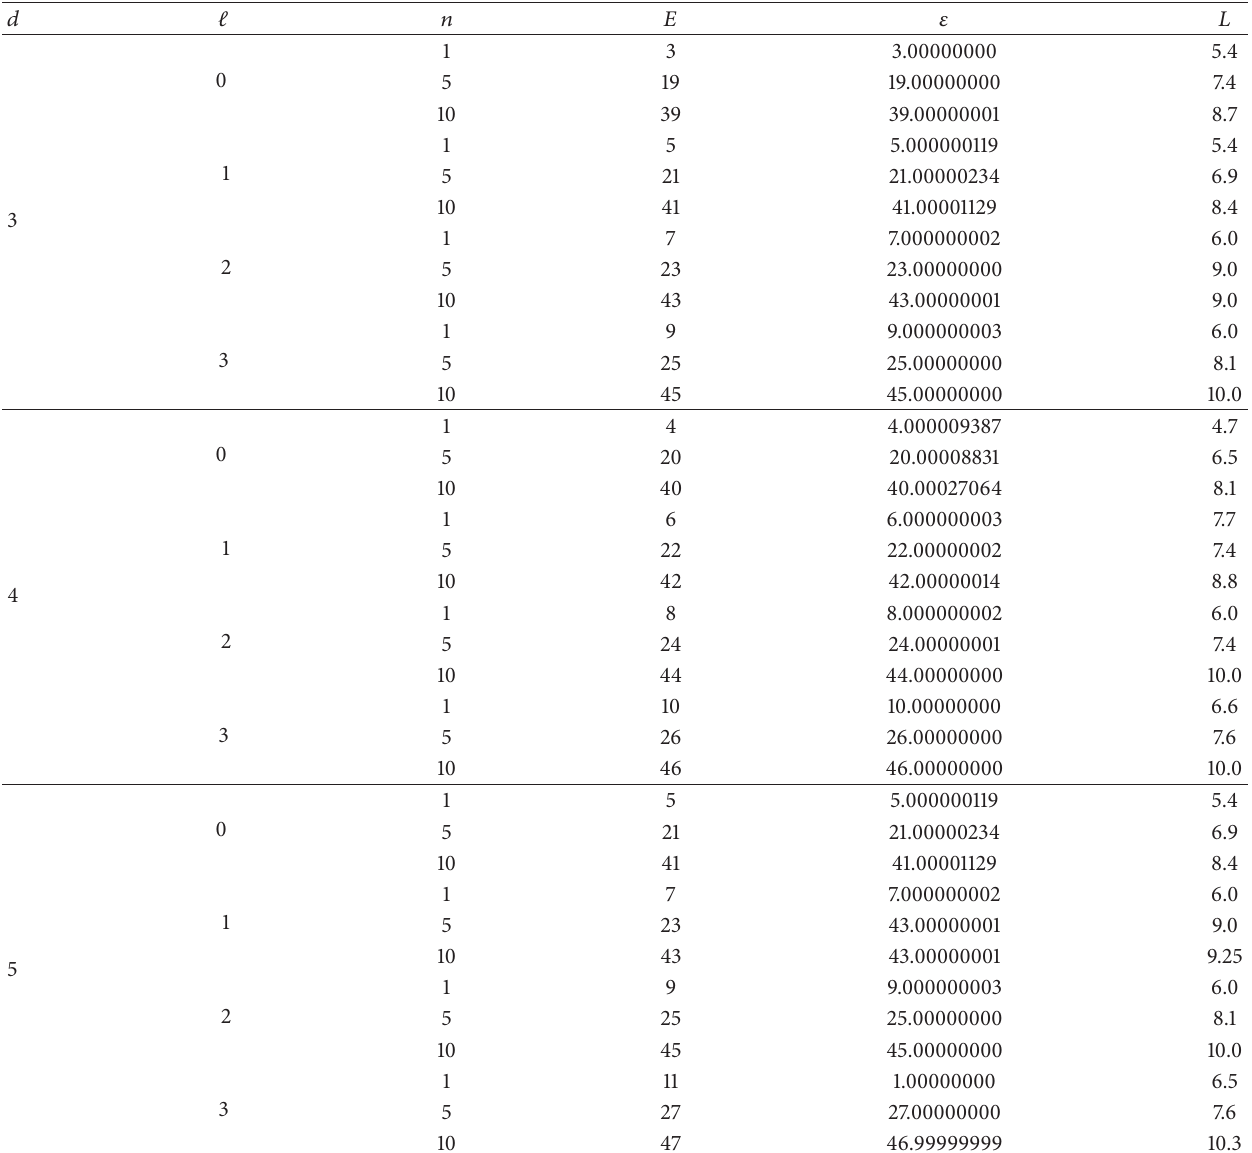
Table 4: Approximation of the energy levels of the harmonic oscillator in dimensions 𝑑 = 3, 4, 5 . 𝑛 represents the energy state, 𝐸 is the exact solution for the energy given by (12), and 𝜀 is the upper bound to 𝐸 obtained using the variational analysis. The eigenvalues 𝜀 𝑛 of H are minimized over 𝐿 . This table shows specific examples of energy values for the quantum numbers ℓ = 0, 1, 2, 3 and energy states 𝑛 = 1, 5,10 . Note that the approximation error has diminished compared with those of Table 3. In the worst case it is of 10 −5 , while in others cases the upper bounds are almost